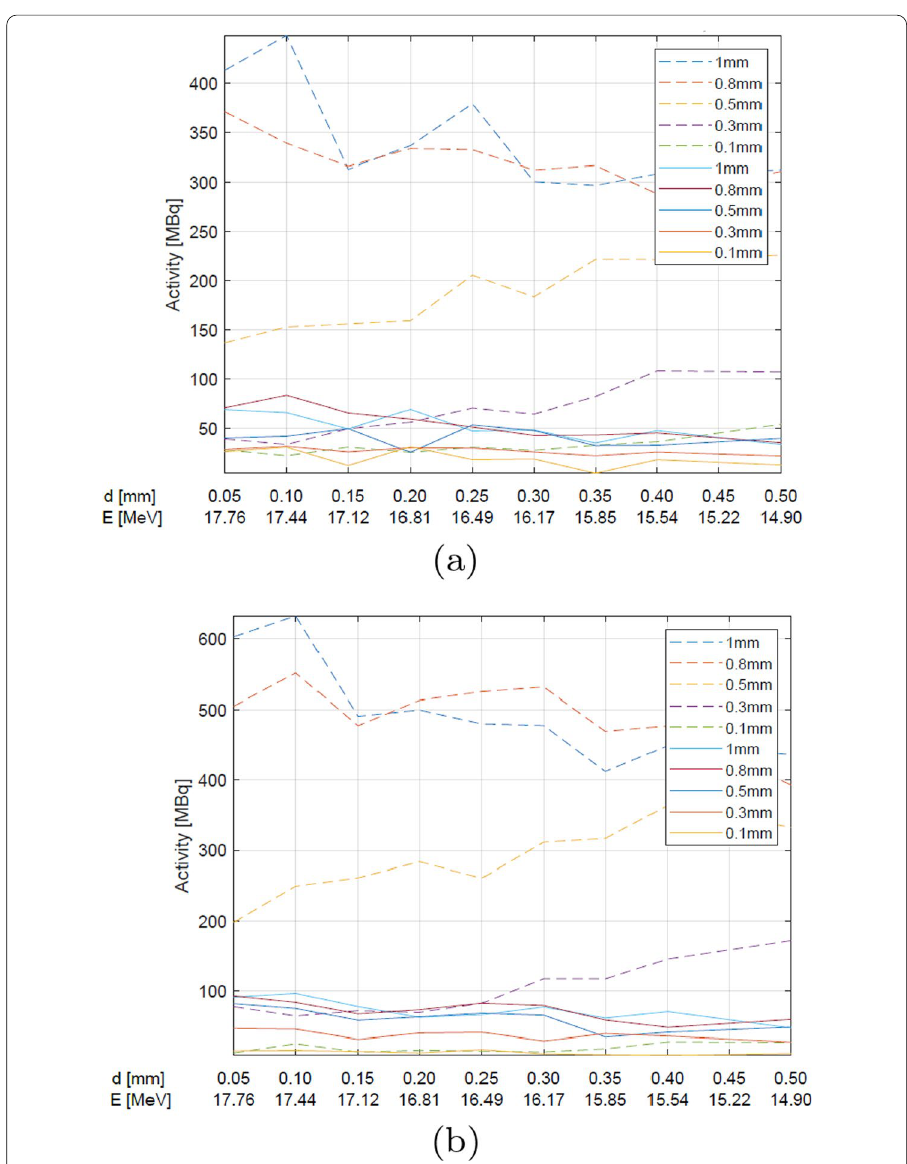
for various target thickness (denoted by various colors as shown in the legend) and various Aluminum foil thickness at the proton current of a 10 μA and b 15